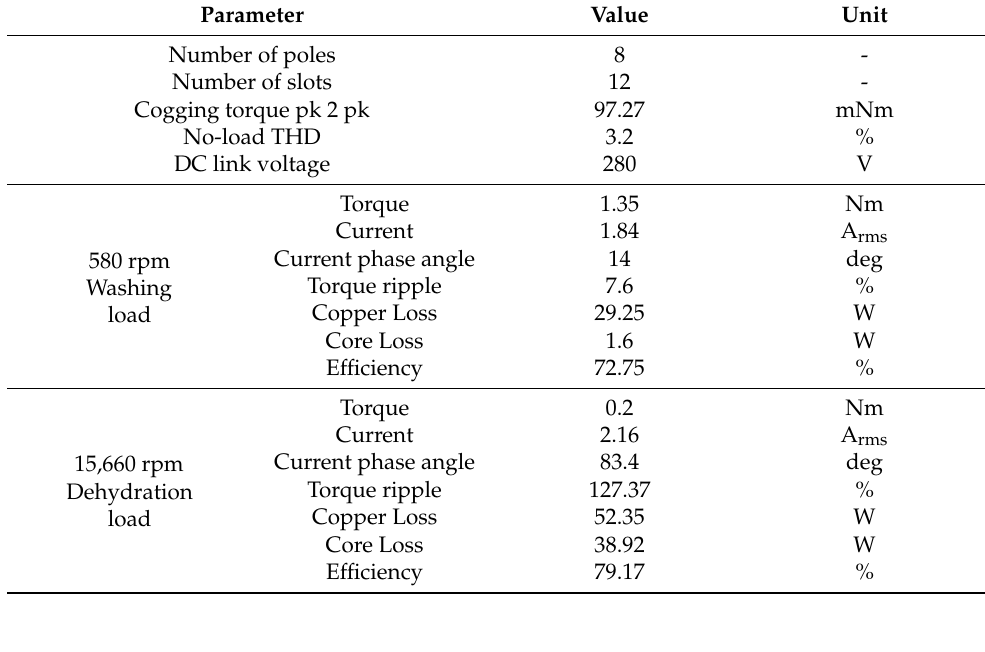
Table 1. Specifications of conventional model.